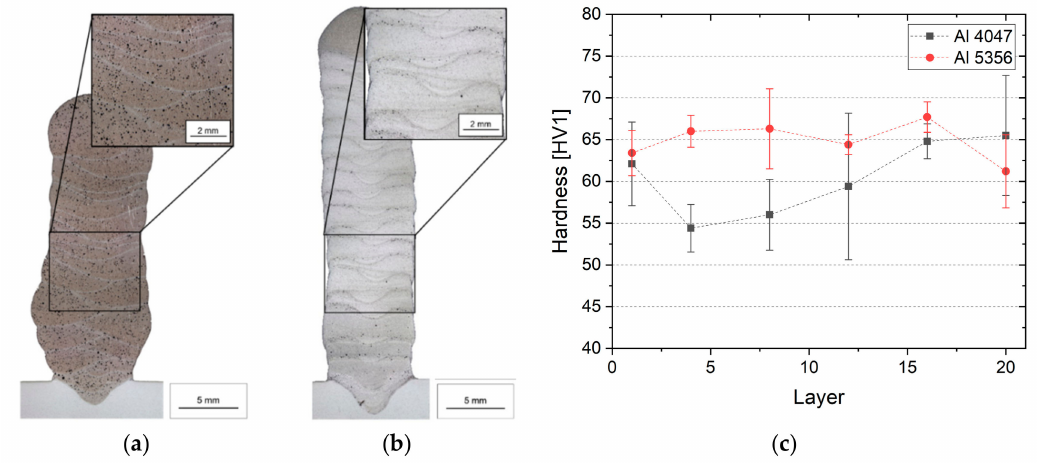
Figure 5. Cross-section micrographs of WAAM samples ( a ) Al-4047, ( b ) Al-5356, and ( c ) hardness distribution depending on buildup